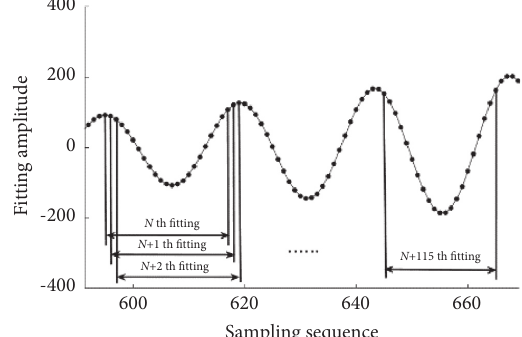
Figure 2: The schematic diagram of fitting